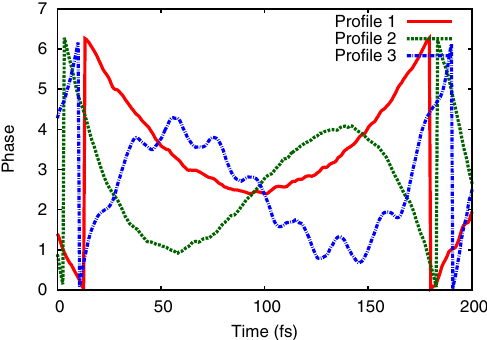
FIG. 7. Radiation characteristics at 2 nm at saturation, showing power (top), phase (middle), and spectrum (bottom). Phases are shown modulo 2 π .